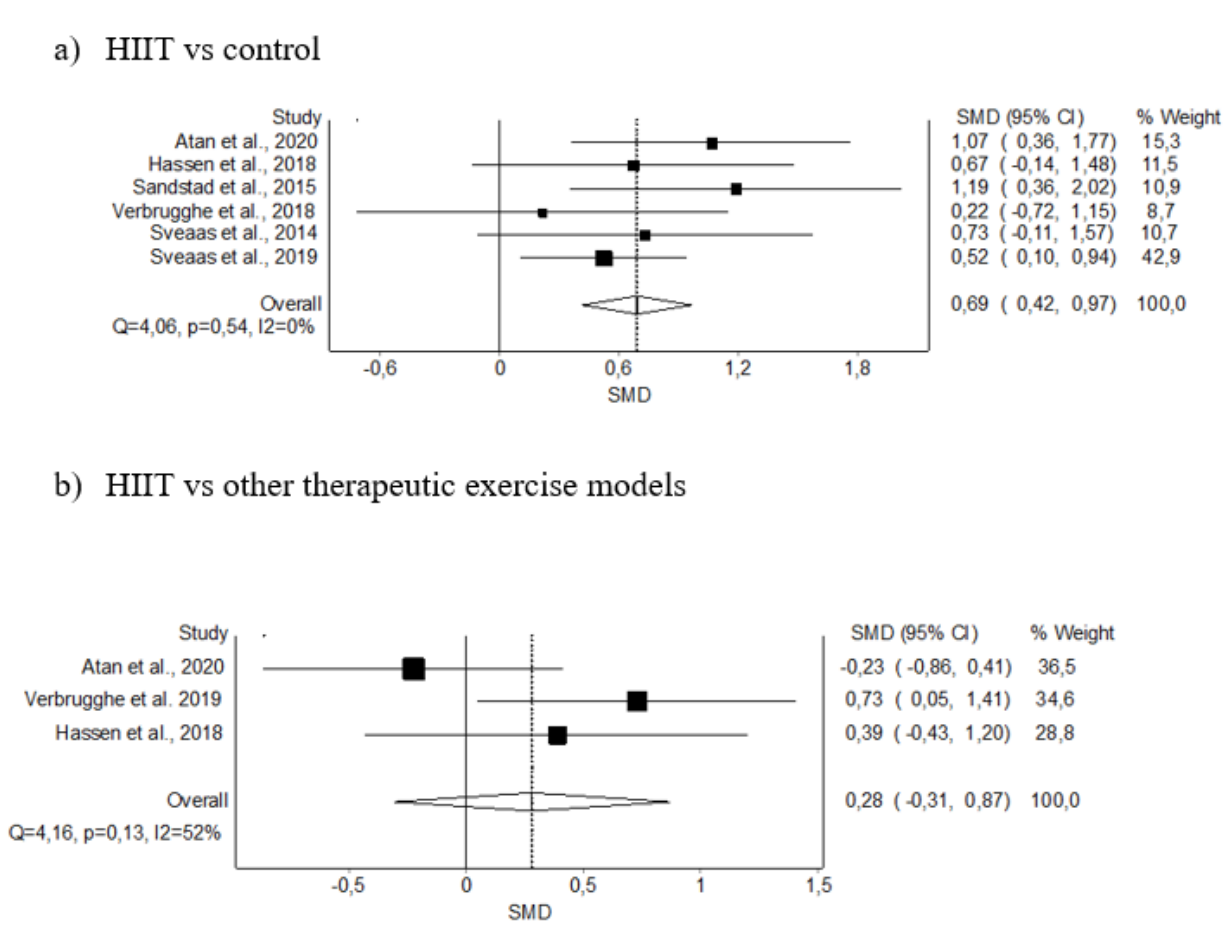
Figure 5. Synthesis forest plot of VO 2 max variable. The forest plot summarises the results of the included studies (sample size, standardised mean differences [SMDs], and weight). The small boxes with the squares represent the point estimate of the effect size and sample size. The lines on either side of the box represent a 95% confidence interval (CI).